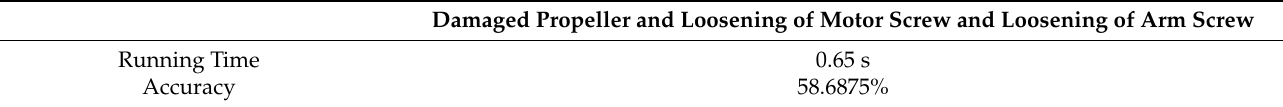
Table 10. The best triple fault kNN classification model based on time-domain data analysis.